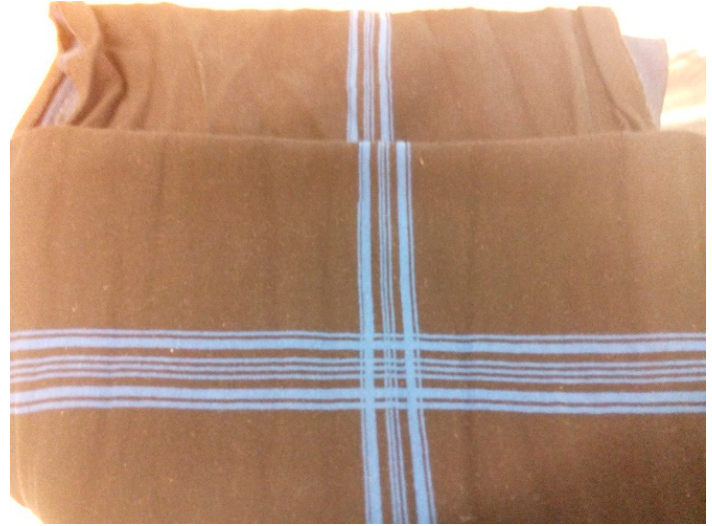
Figure 7. The pattern reproduced in the knit material of a tube scarf. Photograph: author.